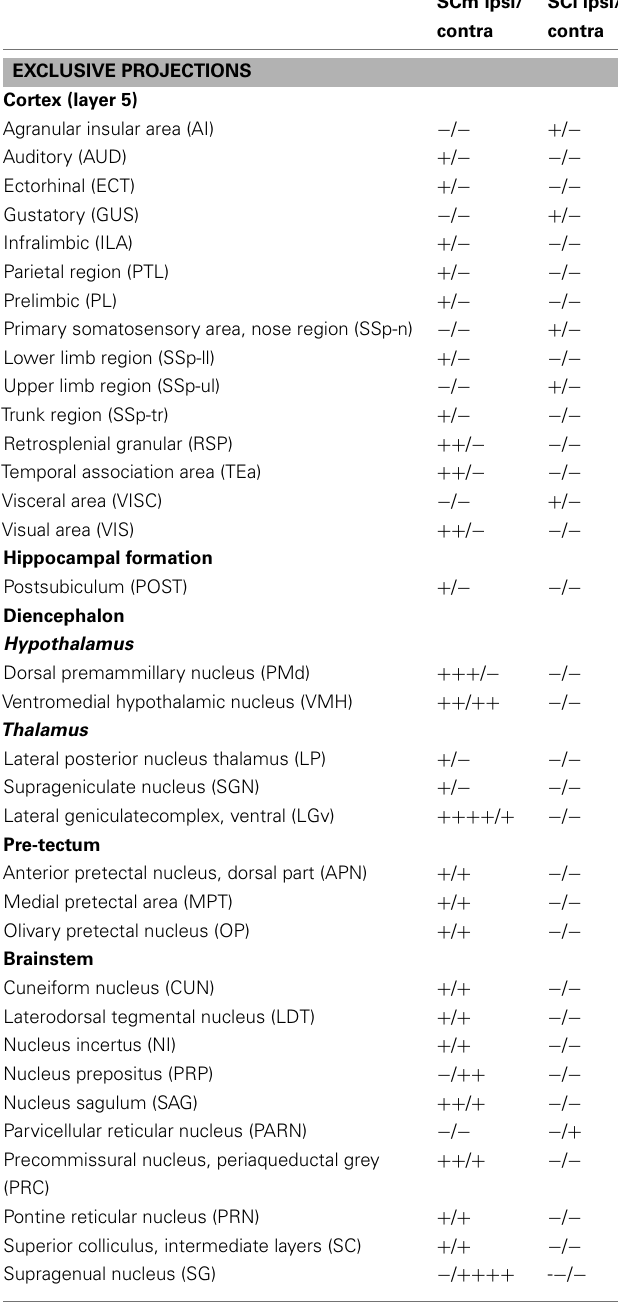
Table 1 | Relative densities of retrogradely labeled cells in the afferent structures for the two cases illustrated in Figure 5 a